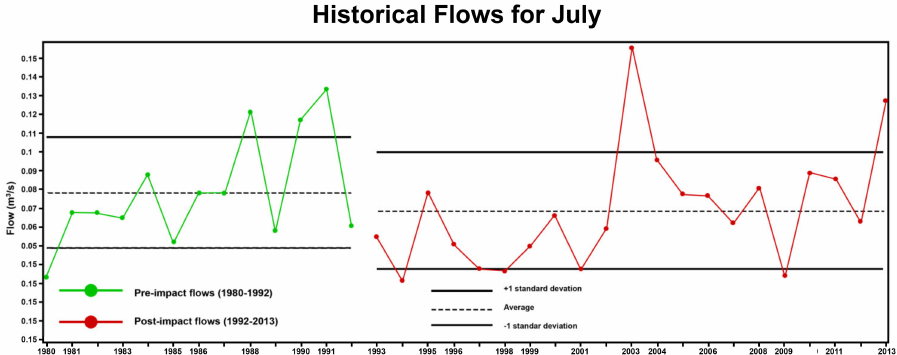
Figure 7. Regime of monthly flow variability for July: the two scenarios of pre- and post-impact for disturbances after urbanization. Limits of +1 and − 1 of standard deviation are